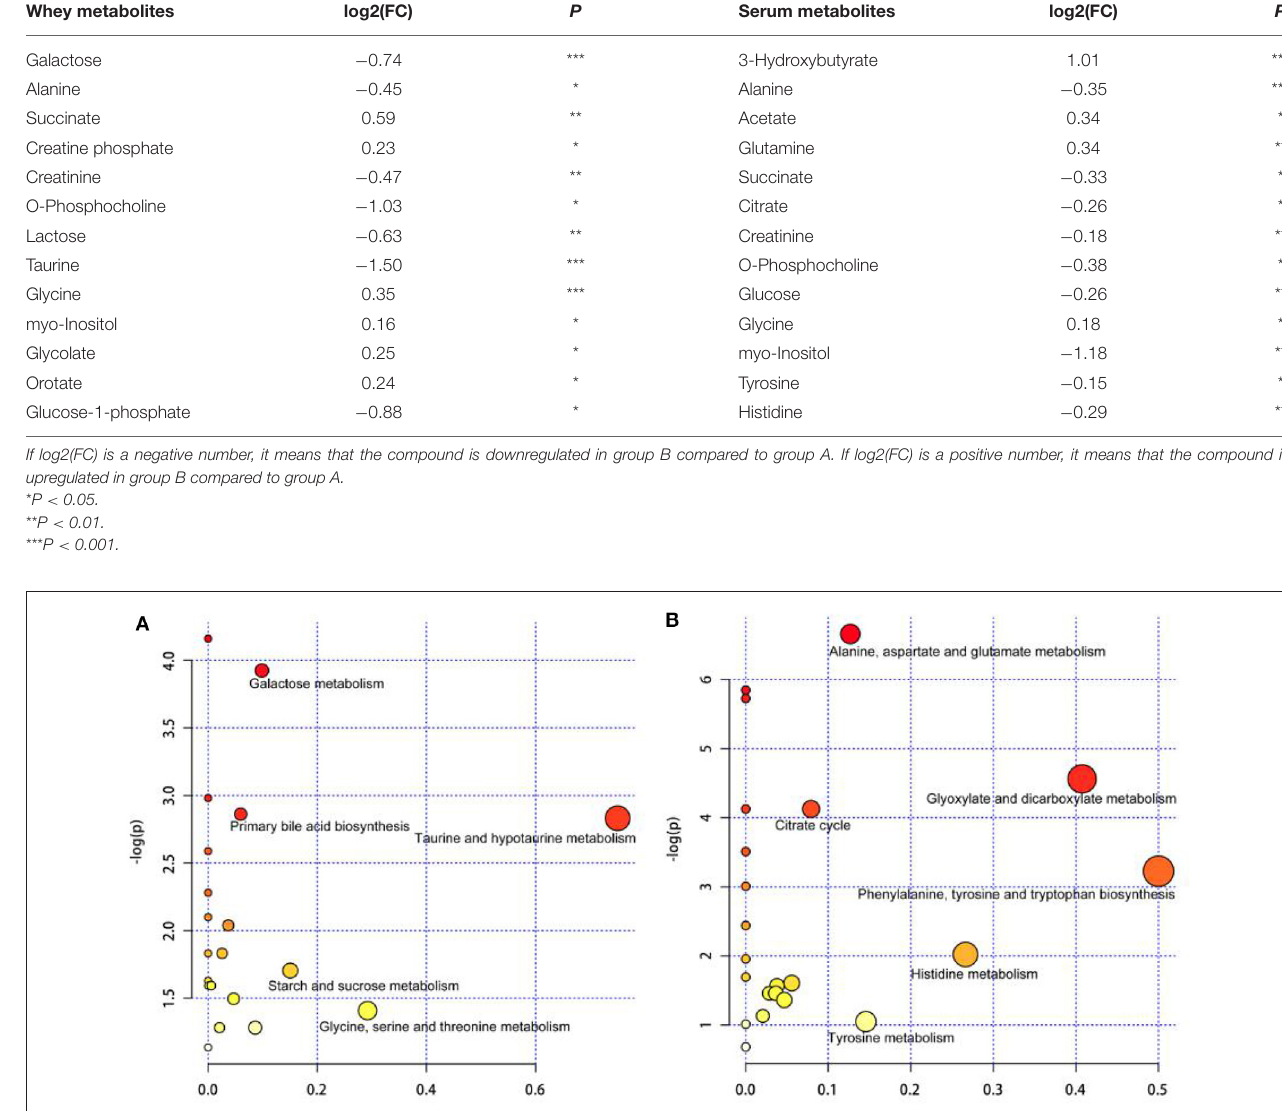
TABLE 1 | Metabolites in the milk whey and serum of dairy cows with inactive ovaries (IO) and estrus. Whey metabolites